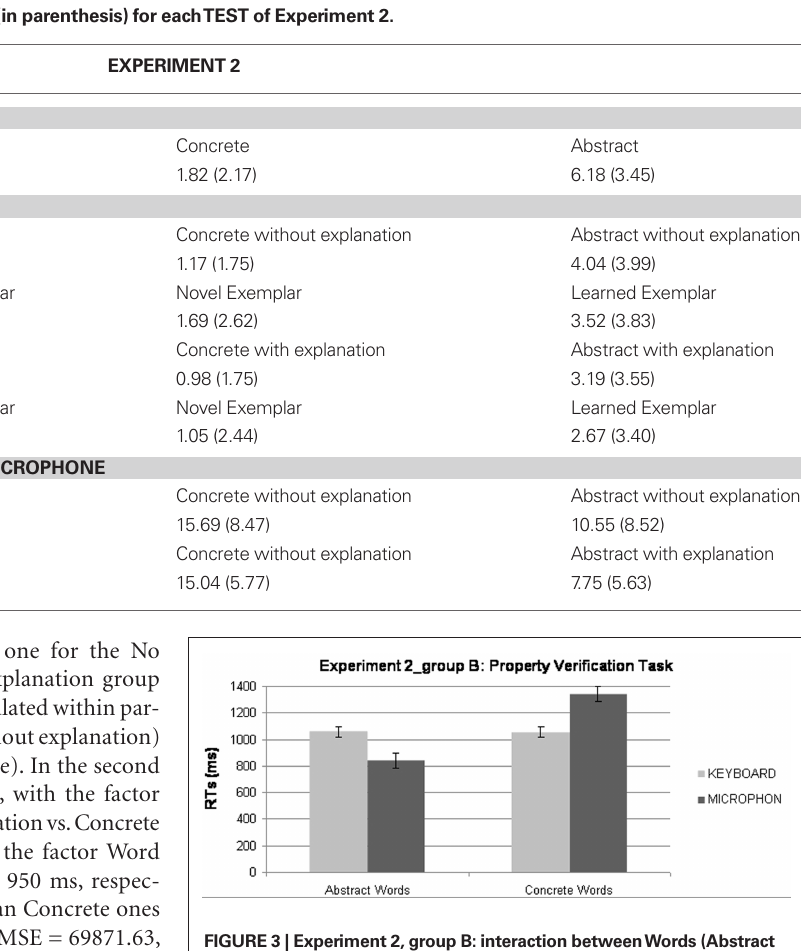
Figure 3 | experiment 2, group B: interaction between Words (Abstract with explanation, Concrete) and response device (Keyboard,